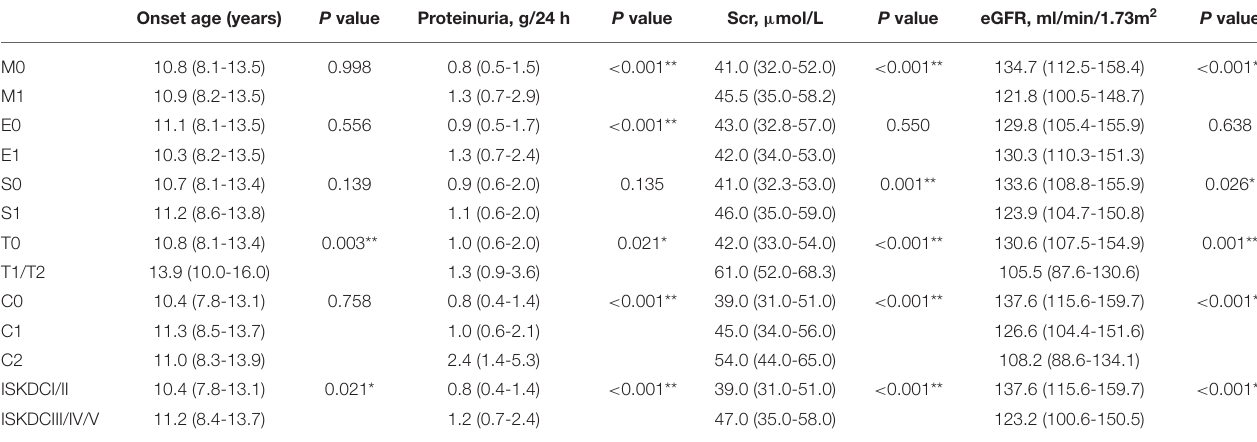
TABLE 3 | Comparison of clinical features at renal biopsy according to two pathological classifications in the children with HSPN. Onset age